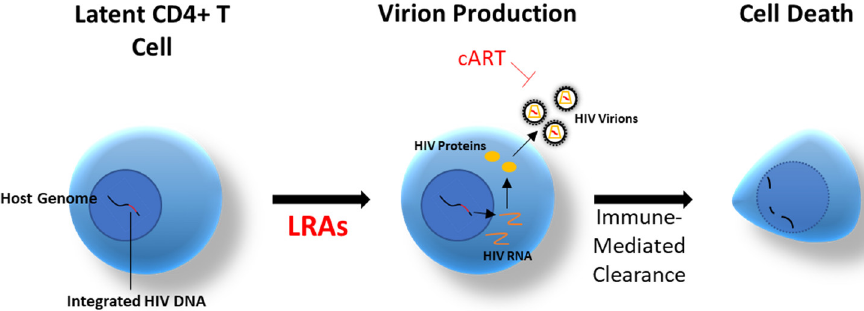
Figure 1. The “Shock and Kill” Strategy uses Latency Reversing Agents for Immune-Mediated Clearance.